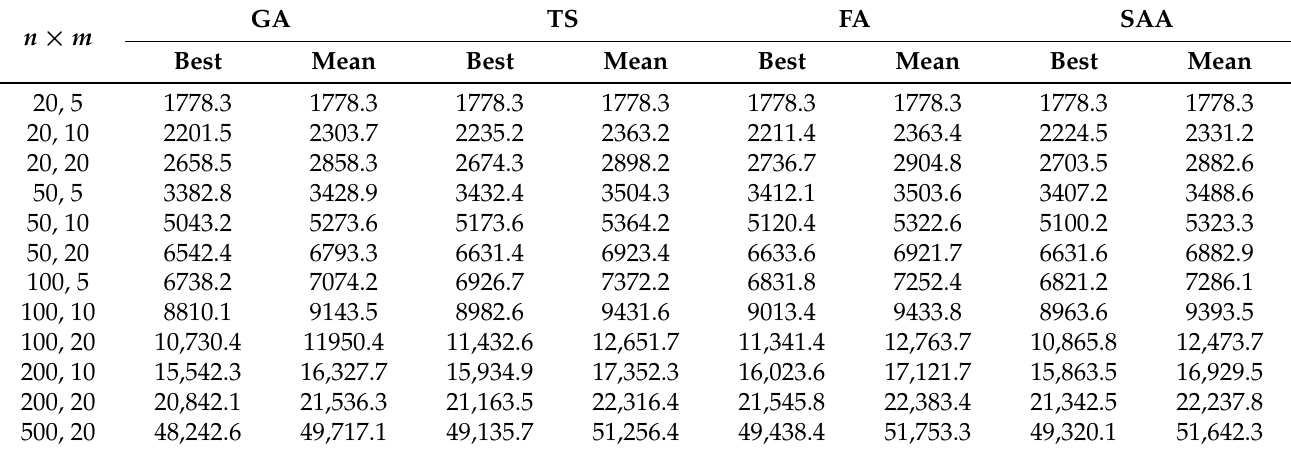
Table 3. Comparison of results with a makespan